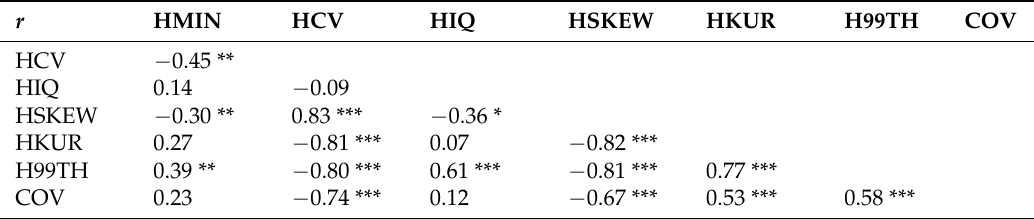
Table 5. Pearson’s correlations among lidar metrics selected.